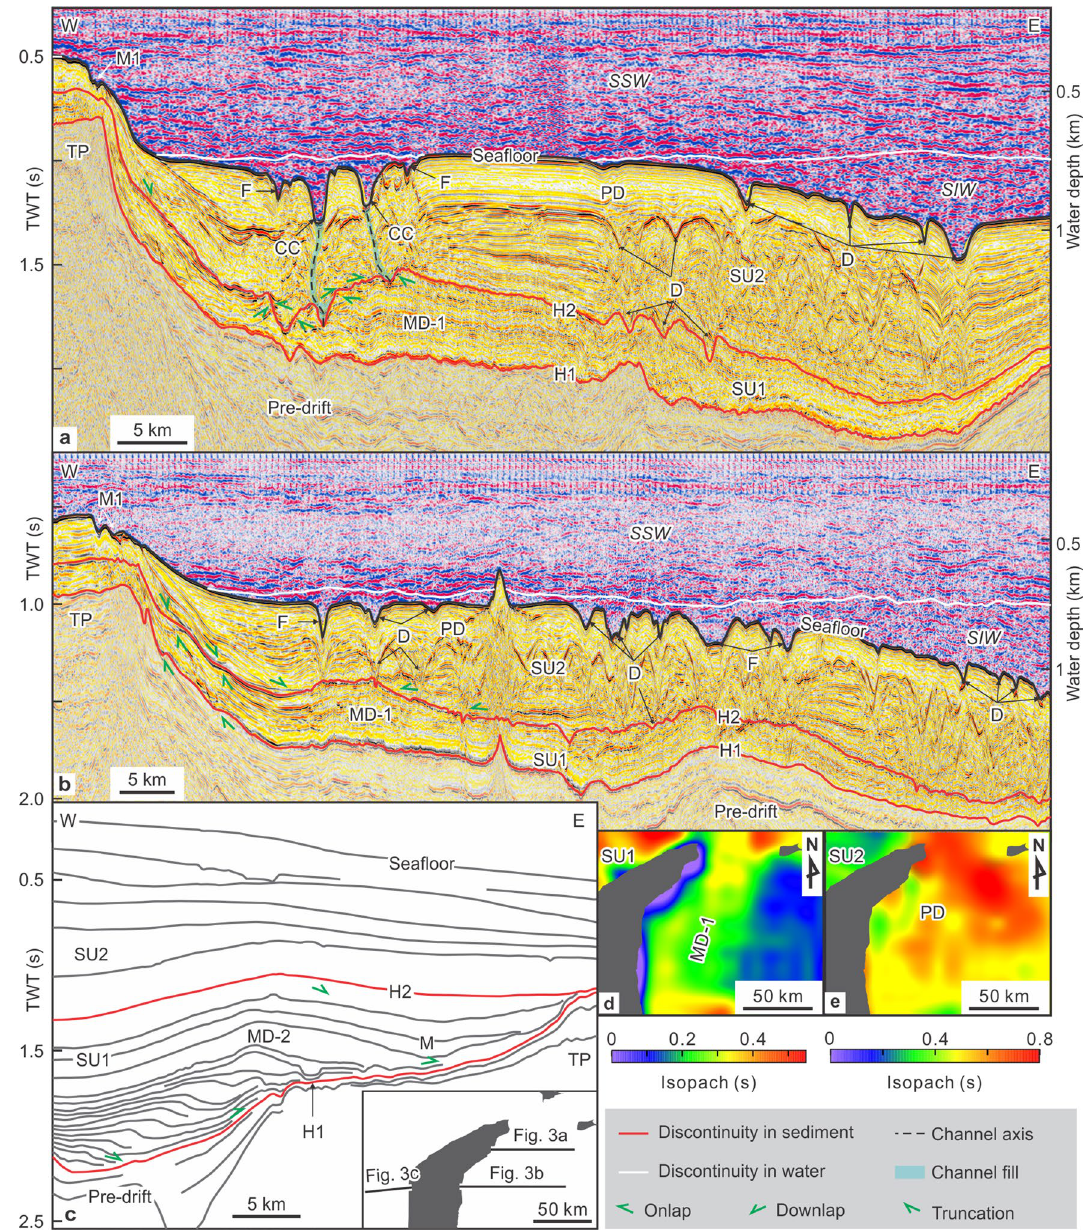
Figure 3. (a,b) Seismic profiles across the eastern flank of the Triton platform; (c) line drawings of a seismic profile across the western flank of the Triton platform (modified from Fyhn et al., 2013 14 ); and (d,e) isopach maps for SU1 and SU2. Abbreviations for water masses, horizons, and seismic units given in text. Abbreviations for sedimentary features referenced to Fig. 2. Profile locations in Figs. 1, 2 and 3c. Seismic images in (a,b) were generated using GeoFrame software (version 4.5, http://slb-sis.com.cn/produ cts-servi ces/GeoFr ame.aspx). The maps in (d,e) were generated using Surfer software (version 13, https ://www.golde nsoft ware.com/produ